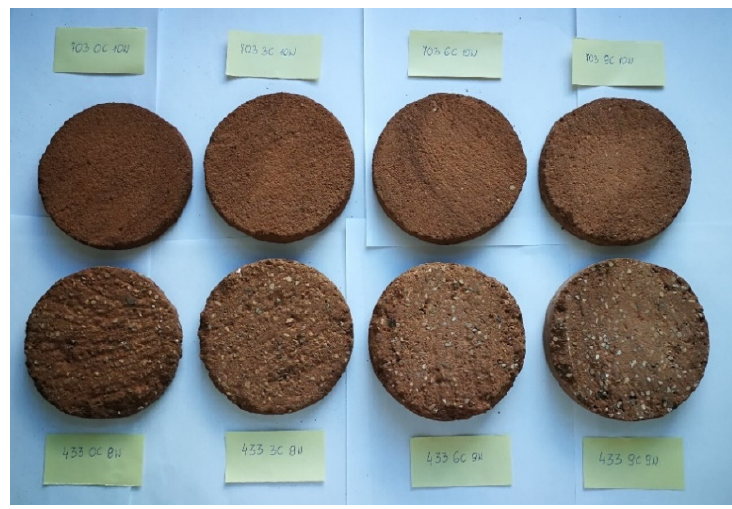
Figure 6. Samples for diffusion resistance coefficient